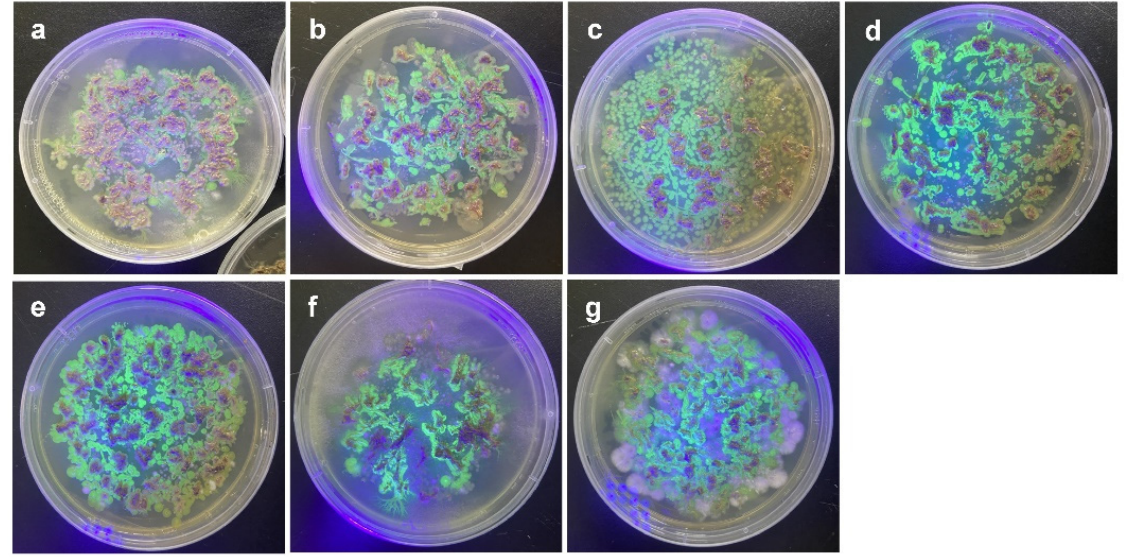
Figure 2. Observation of GFPuv-expressing colonies isolated from bacteria-treated root tissues under UV lamp. ( a ) Pantoea septica YJ1, ( b ) Kosakonia cowanii YJ4, ( c ) Erwinia tasmaniensis YJ6, ( d ) K. cowanii SD1, ( e ) C. dublienesis subsp. lausanneisis MS26, ( f ) K. cowanii GG1, ( g ) P. ananatis GG19.